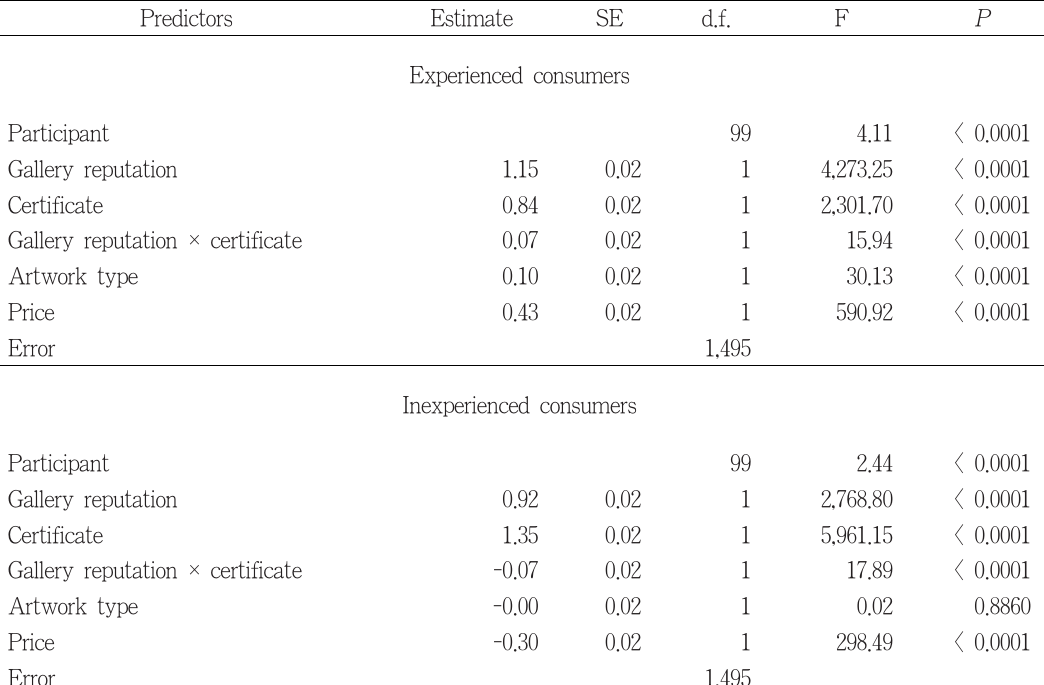
<Table 3> Multiple Regression Analysis Results by Consumer